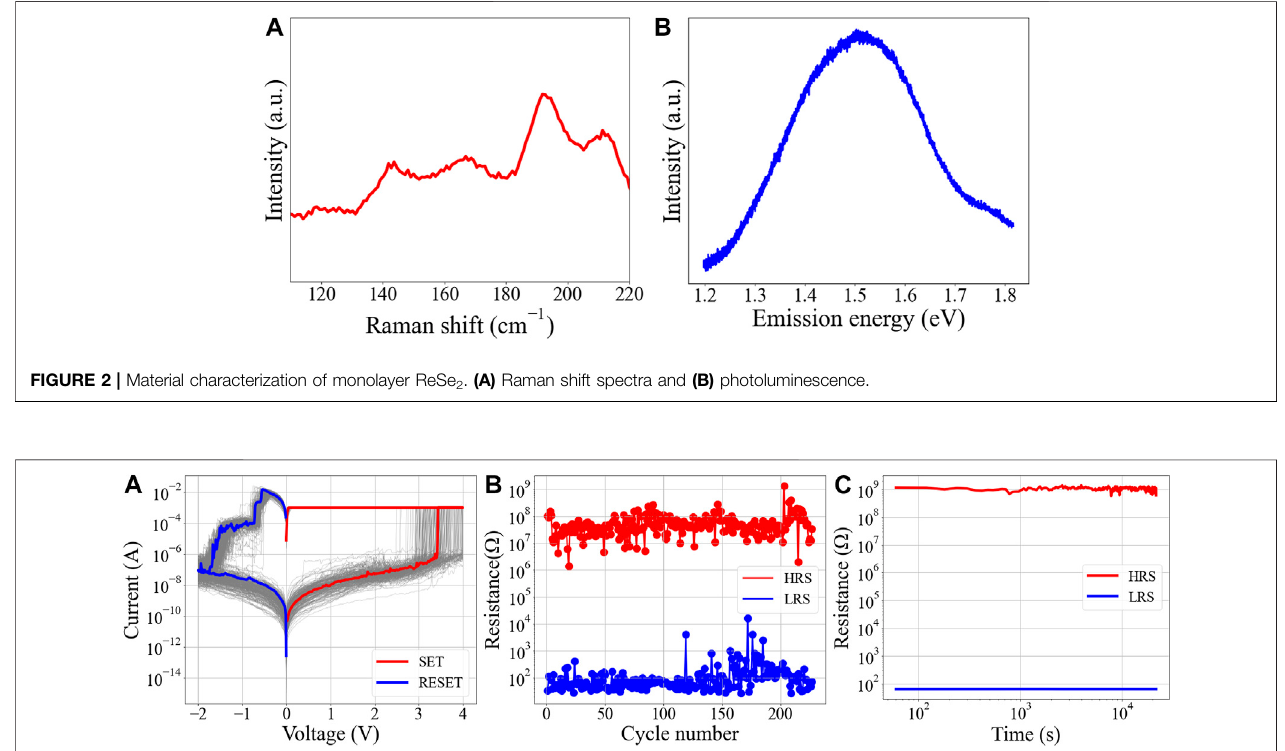
FIGURE3| Electricalcharacteristics ofReSe 2 RRAMdevices. (A) I-VcharacteristicundercyclingDCsweep,indicatinglowcycle-to-cyclevariation. (B) Endurance of ReSe 2 RRAM devices for over 200 cycles. (C) The retention behavior of ReSe 2 RRAM devices for over 6 h at ambient condition.